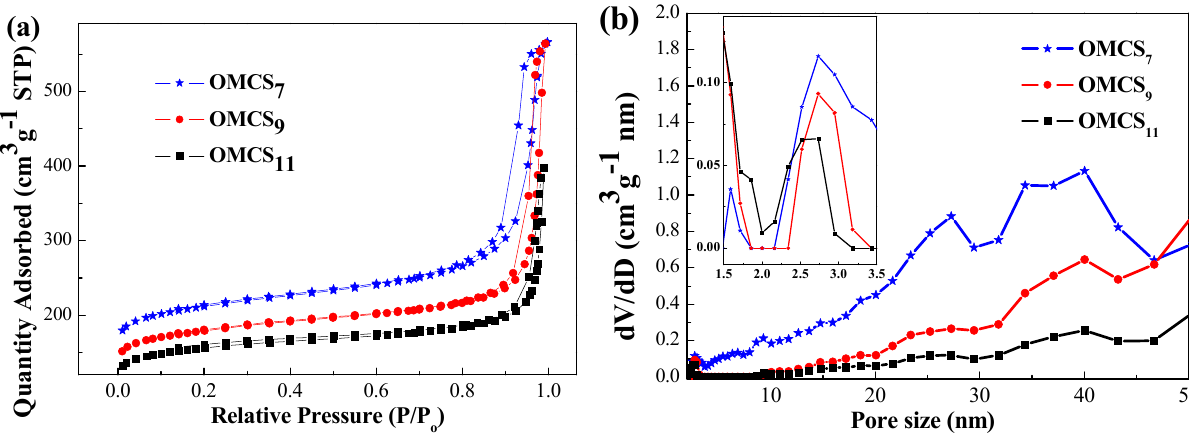
Figure 3. ( a ) The N 2 adsorption-desorption isothermals and ( b ) pore size distributions of OMCS x